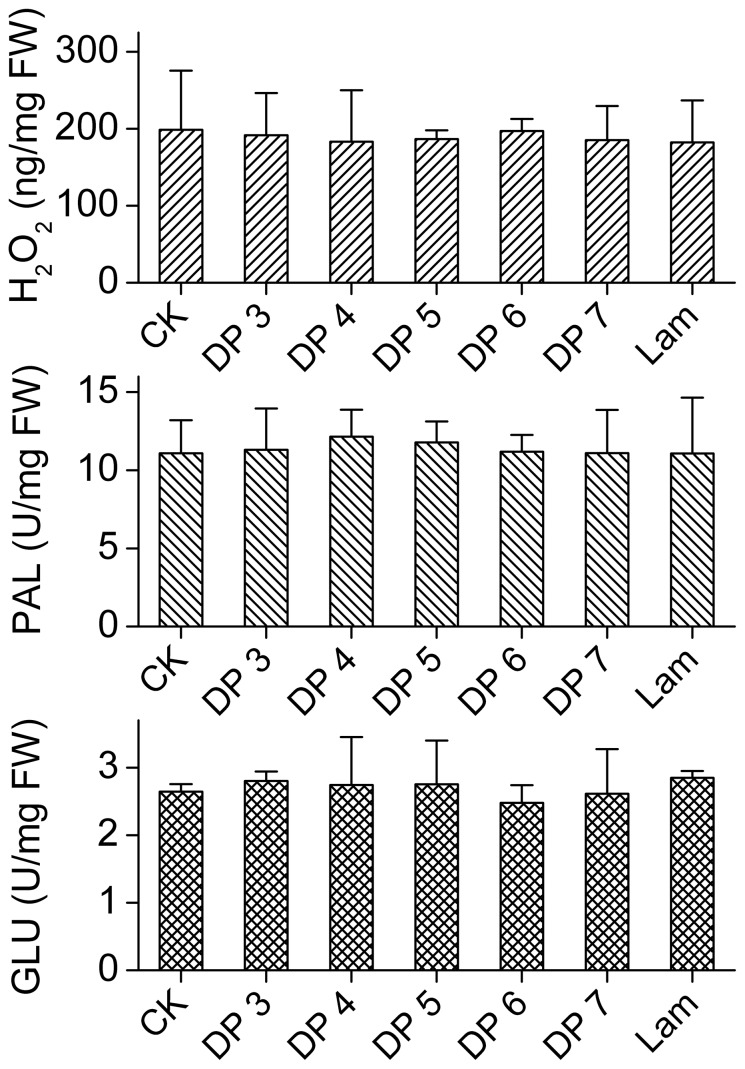
Long-term defense activities of potato in response to elicitors.The potato leaves were treated with various curdlan oligosaccharides (degree of polymerization (DP) from 3 to DP 7). Sampling was done at 20 d after elicitation for each set. Potato leaves treated with deionized water were used as elicitor-free control, CK. All tests were carried out in triplicates. PAL, phenylalanine ammonia-lyase; GLU, β-1,3-glucanase. Values are means±SD. Lowercase letters indicate significant differences (LSD test at p<0.05).